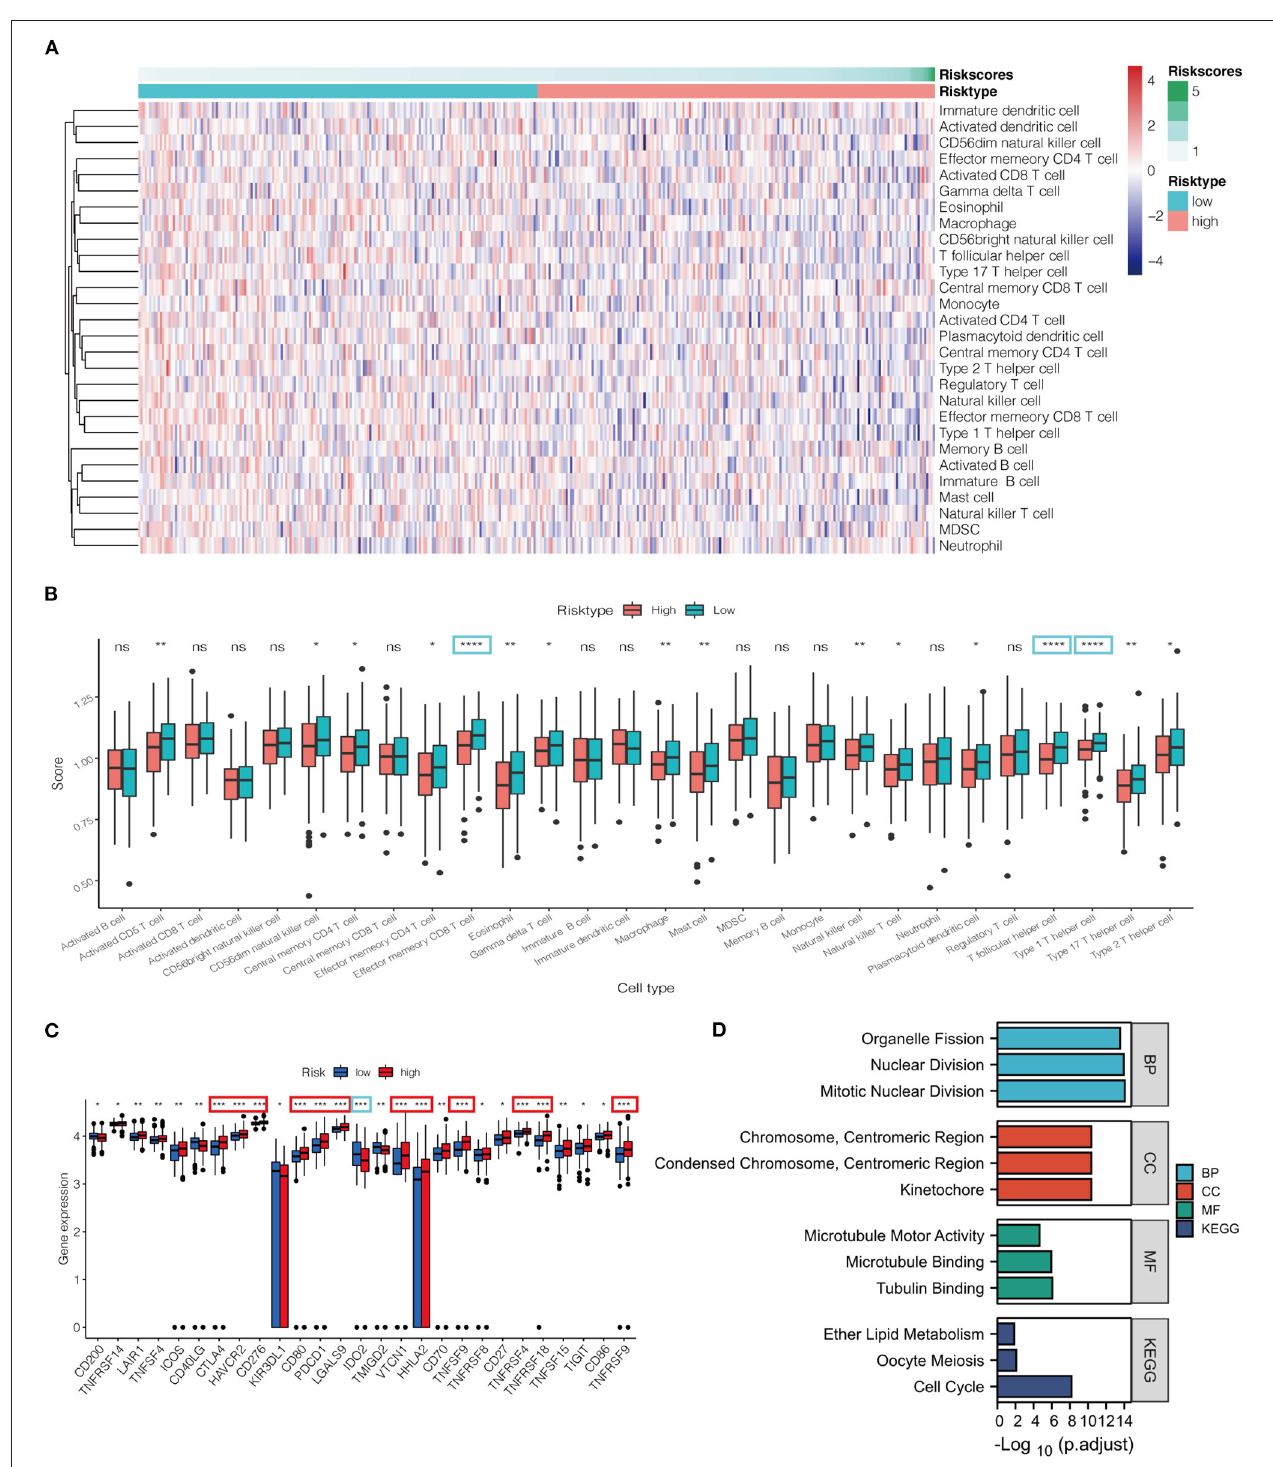
FIGURE 5 | (A) Heatmap for immune responses based on ssGSEA algorithms between low- and high-risk groups. (B) ssGSEA for the association between immune cell subpopulations and related functions among the two groups. (C) Expression of immune checkpoints risk groups between the two risk groups. (D) Barplot graph for GO enrichment and KEGG pathway analysis (the more extended bar means the more genes enriched). * P < 0.05, ** P < 0.01, *** P < 0.001, **** P < 0.0001, ns, not statistically significant; p. adjust: the p -value adjustment; GO, Gene Ontology; KEGG, Kyoto Encyclopedia of Genes and Genomes; BP, biological process; CC, cellular component; MF, molecular